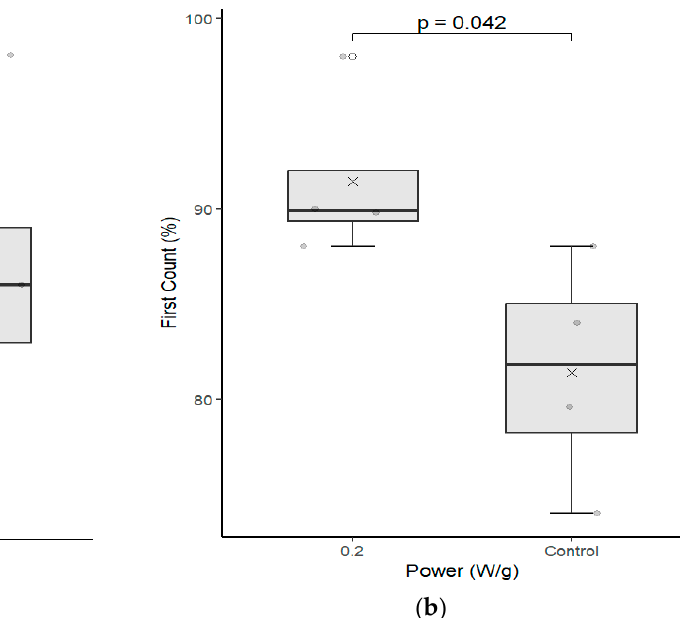
Figure 2. Germination pattern test (GPT). ( a ) Total germination; ( b ) normal seedlings in the first count test; ( c ) abnormal seedlings. C—control group; EM—electromagnetic bio stimulation (magneto-priming). Average followed by the same later end color do not differ significantly by the Fisher’s LSD test.